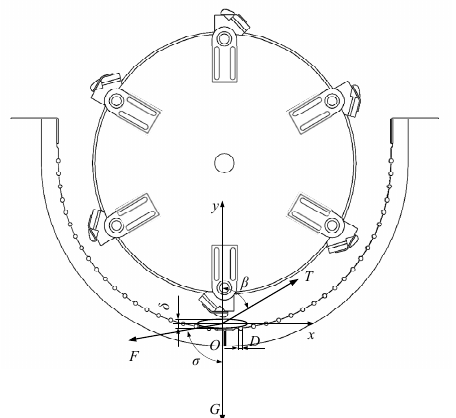
Figure 5. Stress analysis diagram of the detached sunflower disc.